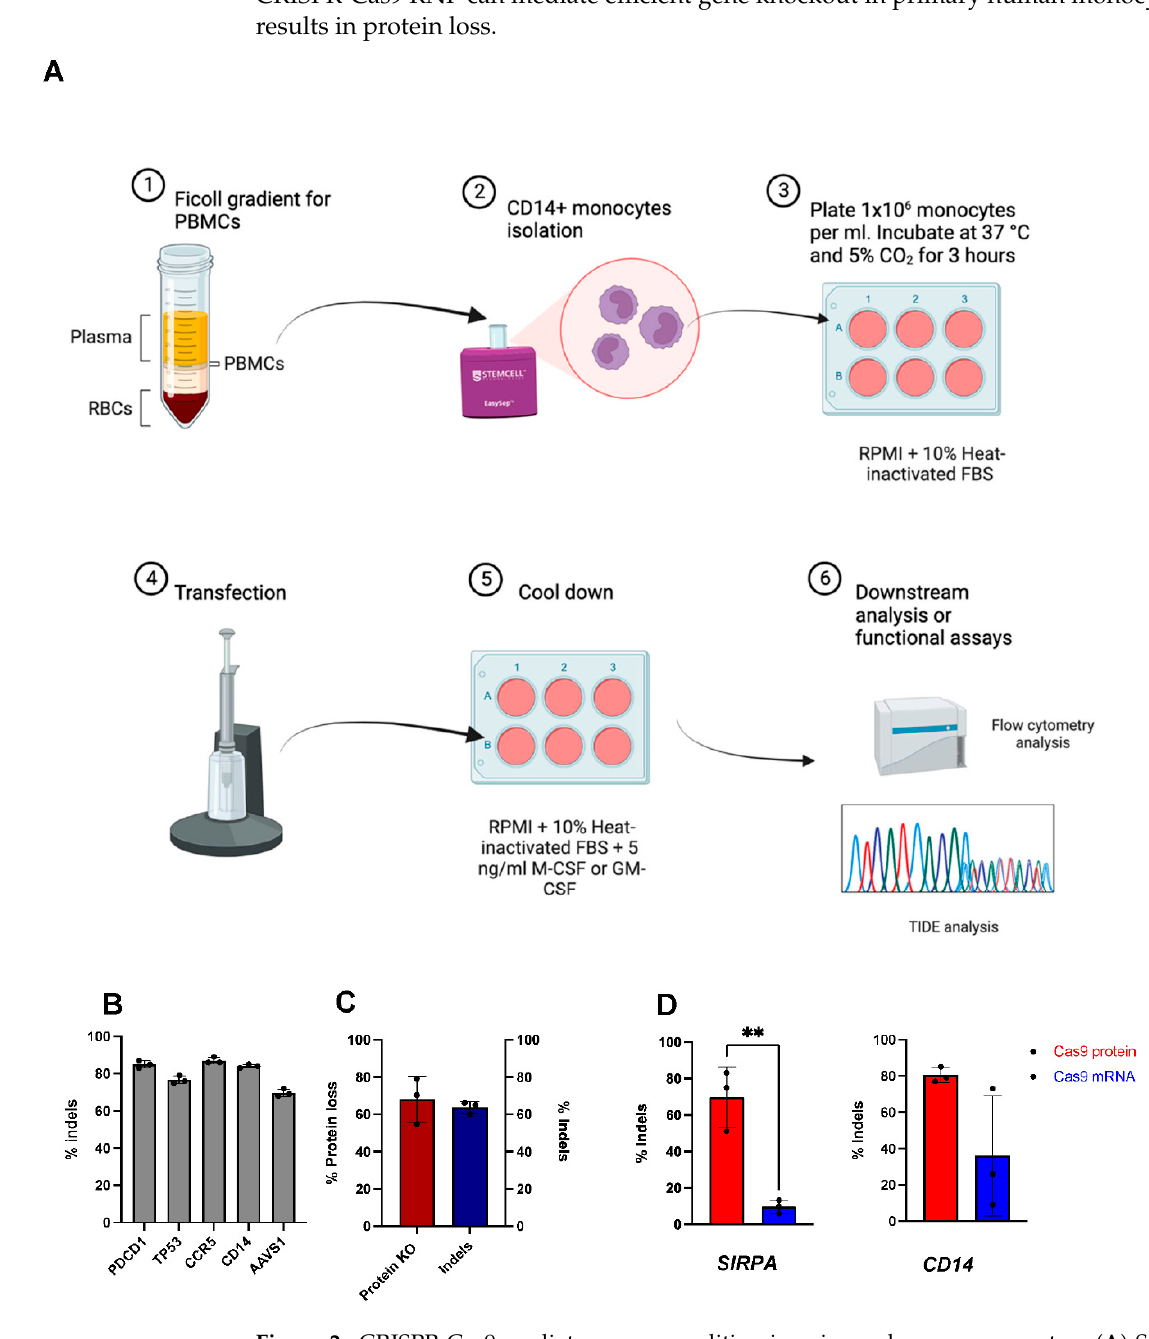
Figure 2. CRISPR-Cas9 mediates genome editing in primary human monocytes. ( A ) Schematic de- picting monocyte editing workflow. Monocytes are isolated from PBMCs of healthy human donors and then electroporated with GFP mRNA or Cas9 and sgRNA targeting gene of interest. Electro- porated cells are then analyzed for gene editing and protein loss. ( B ) Percent indel formation of gene targeted for CRISPR-Cas9 RNP editing as measured by TIDE. ( C ) Bar graphs showing levels of pro- tein loss (left bar) and indel formation (right bar) ( p = 0.6735) post Cas9 RNP targeted SIRPa KO. ( D ) Bar graph depicting the level of indel formation at SIRPA and CD14 after treatment with Cas9 RNP or Cas9 mRNA and either SIPRA or CD14 sgRNA (n = 3 independent biological donors) (** p < 0.01). Statistical analyses were conducted using unpaired Welch’s t test.